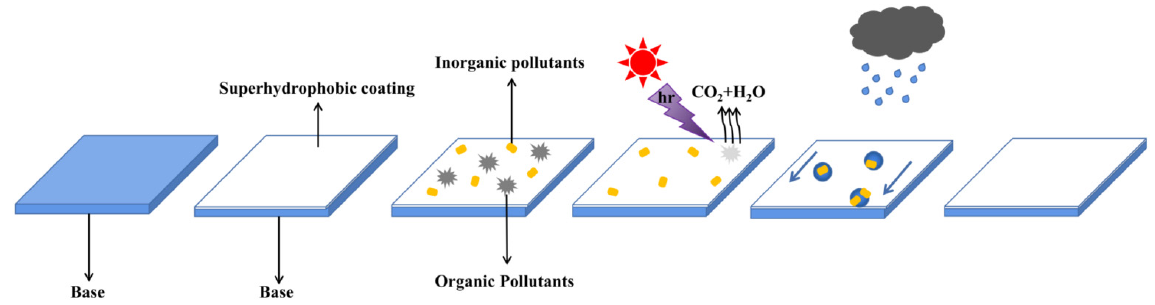
Figure 3. Schematic diagram of the self-cleaning process.